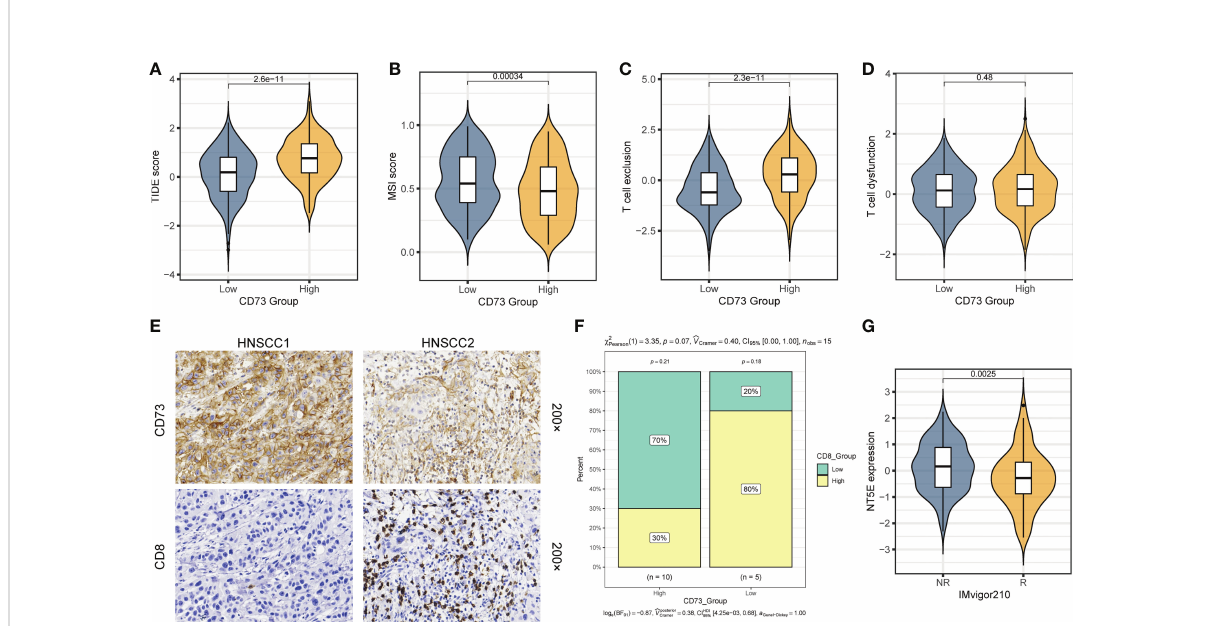
FIGURE 4 CD73 could be a predictor for the immunotherapy response. (A) Comparison of TIDE score between two groups. (B) Comparison of MSI score between two group. (C) Comparison of T cell exclusion score between two groups. (D) Comparison of T cell dysfunction score between two group. (E) Representative images of CD73 expression and CD8 + T cell in fi ltration in HNSCC tissues. (F) Compare the difference in the proportion of CD8 + T cells between the CD73-high group and the CD73-low group. (G) Comparison of the NT5E expression between response (R) group and non-response (NR) group in IMvigor210